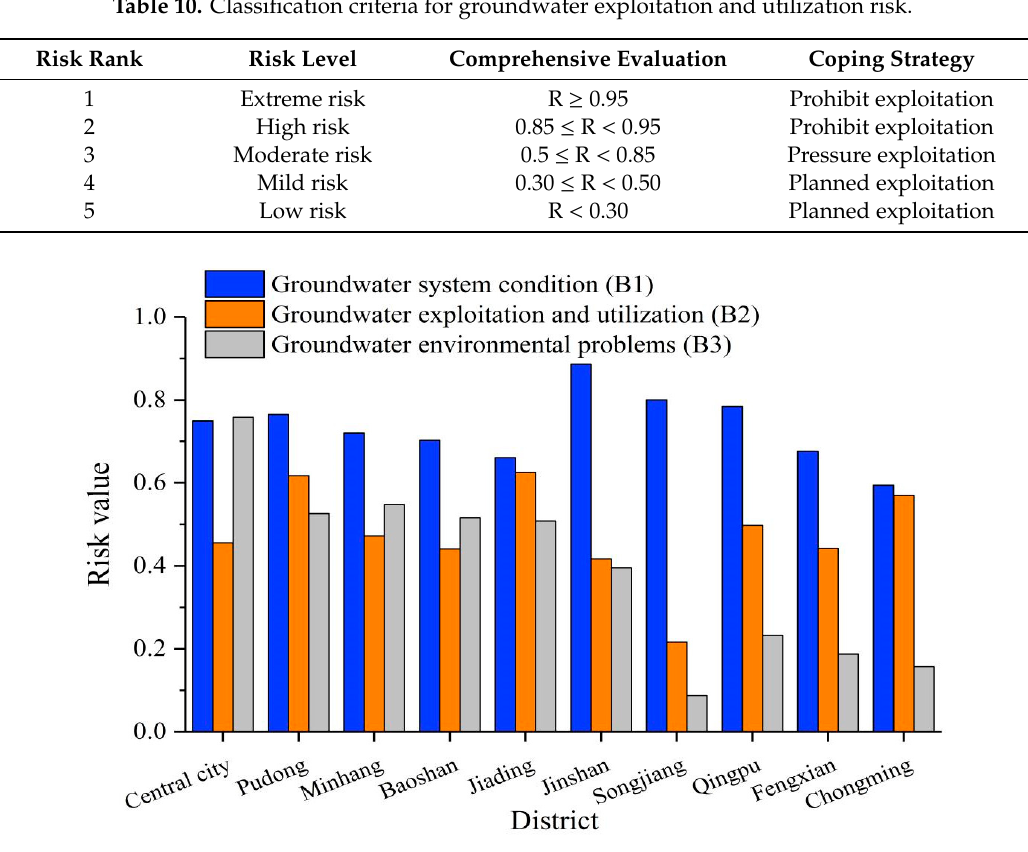
Figure 7. Criteria layer risk values for groundwater exploitation and utilization risk in Shanghai.